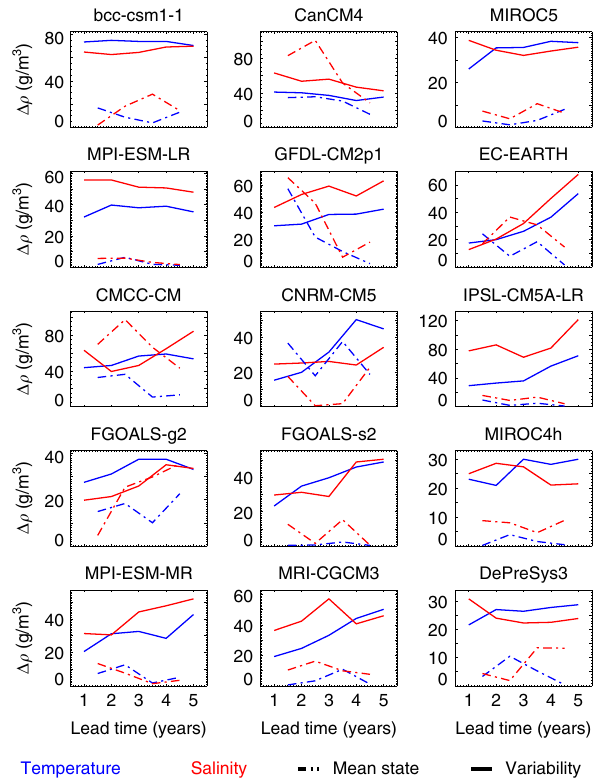
Fig. 3 The relative roles of the mean state and the variability. Contributions from changes in the mean state (dot-dashed) or changes in the variability (solid) from temperature (blue) and salinity (red) to characteristic density changes in the hindcasts as a function of lead